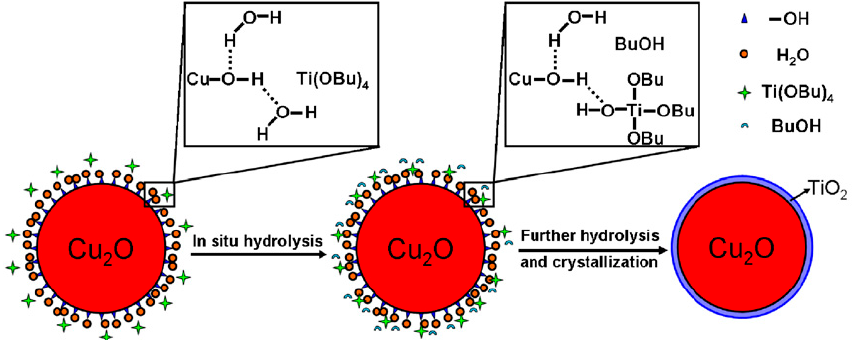
Figure 13. The formation of compact interface between two components ascribed as in situ hydrolysis and crystallization synthetic method of core ‐ shell Cu 2 O@TiO 2 . Reprinted with permission from [101]. Copyright Elsevier, 2011.